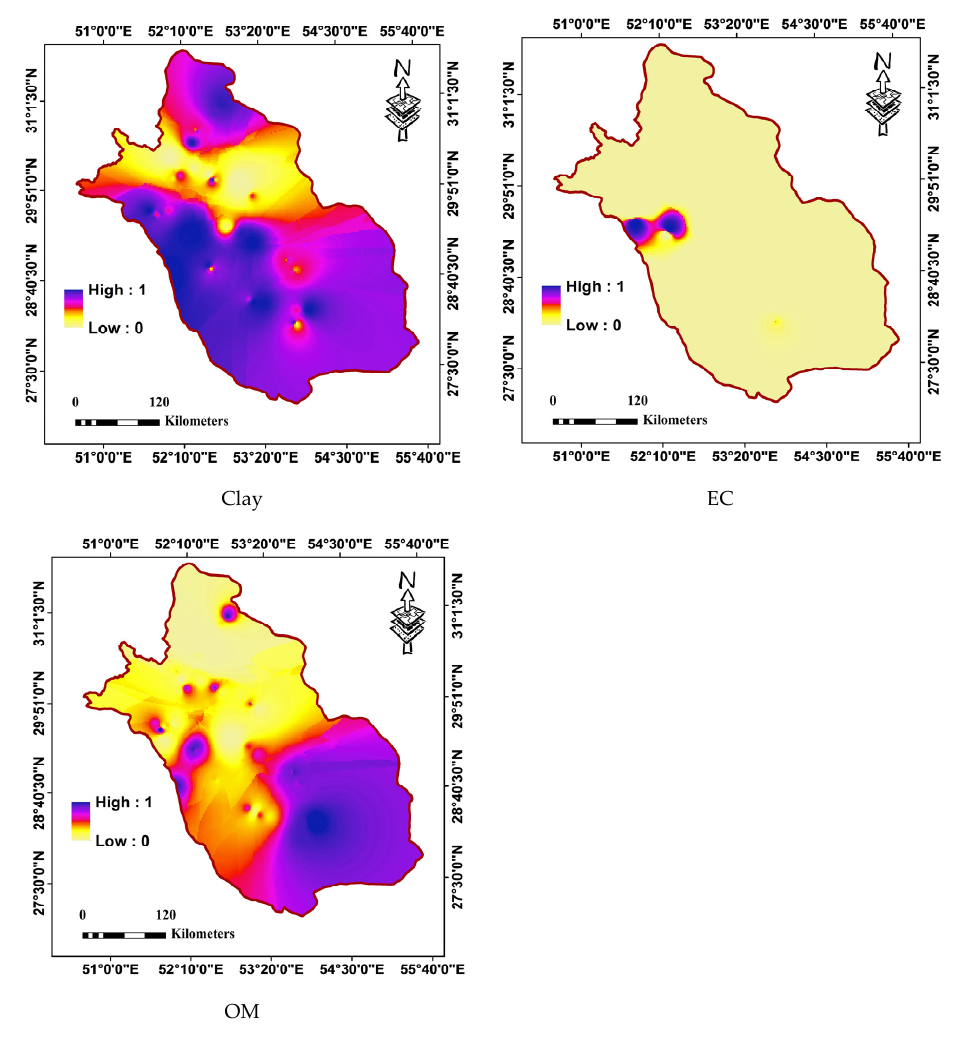
Figure 4. The fuzzy maps of each parameter for estimation of KSP. Table 4. Pair ‐ wise comparison matrix for KSP.